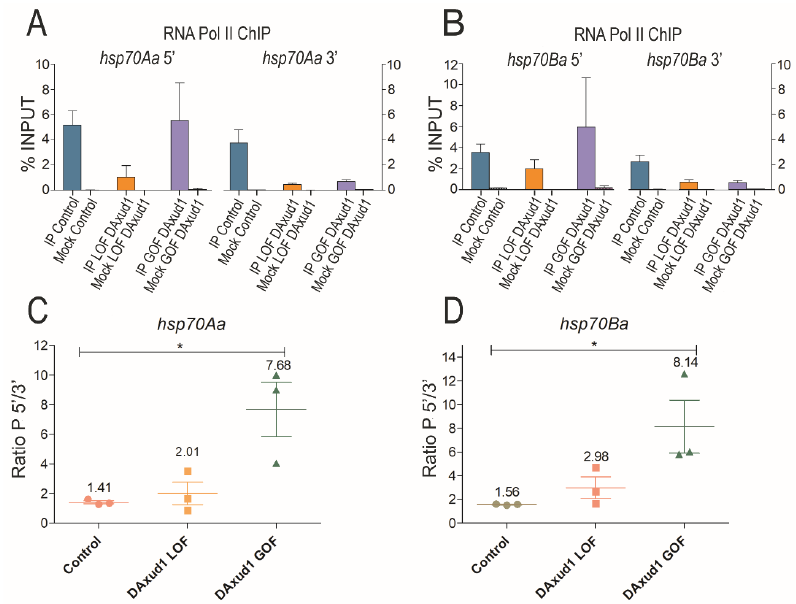
Figure 4. Unphosphorylated RNA Polymerase II chromatin immunoprecipitation (ChIP). Assays were performed in control conditions of 25 °C, loss of function by RNAi knockdown (LOF), and gain of function overexpressing DAxud1-GFP (GOF). The ChIPs were performed for TSS-5′ and -3′ regions of hsp70Aa ( A ) and hsp70Ba ( B ). The % input from the RNA Polymerase IP was used to obtain a ratio of 5 (cid:48) and 3 (cid:48) for hsp70Aa ( C ) and hsp70Ba ( D ) in which mean is above the groups. One way ANOVA analysis was performed in groups from panels C and D. * for p value <